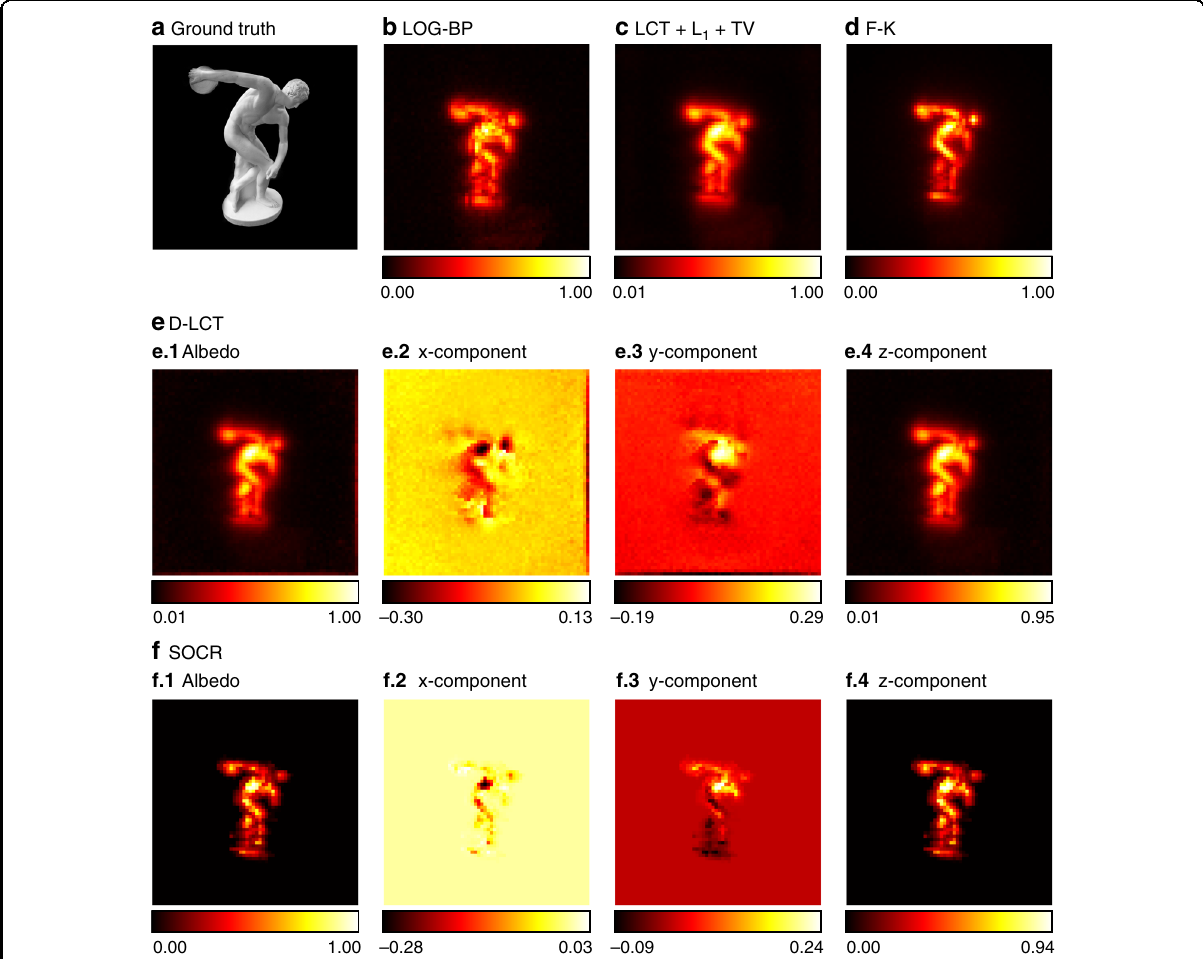
Fig. 8 Reconstruction results of the statue (confocal, 10min). The ground truth is shown in a . Reconstructions are shown in b – f . Our reconstruction has the highest contrast, with clear local structures and less noise outside the target. The three components of our reconstruction are jointly sparse due to the sparseness prior imposed on the